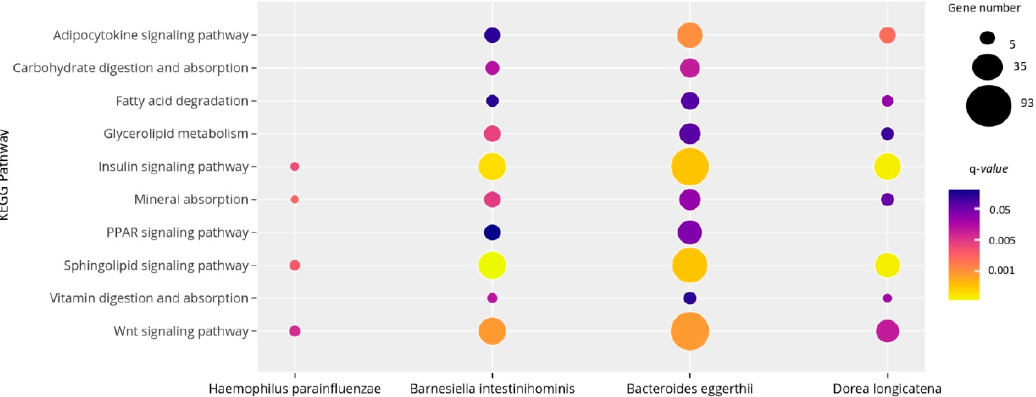
Figure 4. Significant KEGG pathways regulated by the 14 miRNAs correlated with bacteria differentially expressed in subjects with obesity. The size and the color of the dots represent the gene number and the range of the pathway’s q -value, respectively. The y -axis represents the KEGG pathways and the x -axis shows the 4 bacterial species associated with each selected pathway. q -values: p -values corrected for multiple tests using the Benjamini–Hochberg method. This figure was performed using ploty.com.